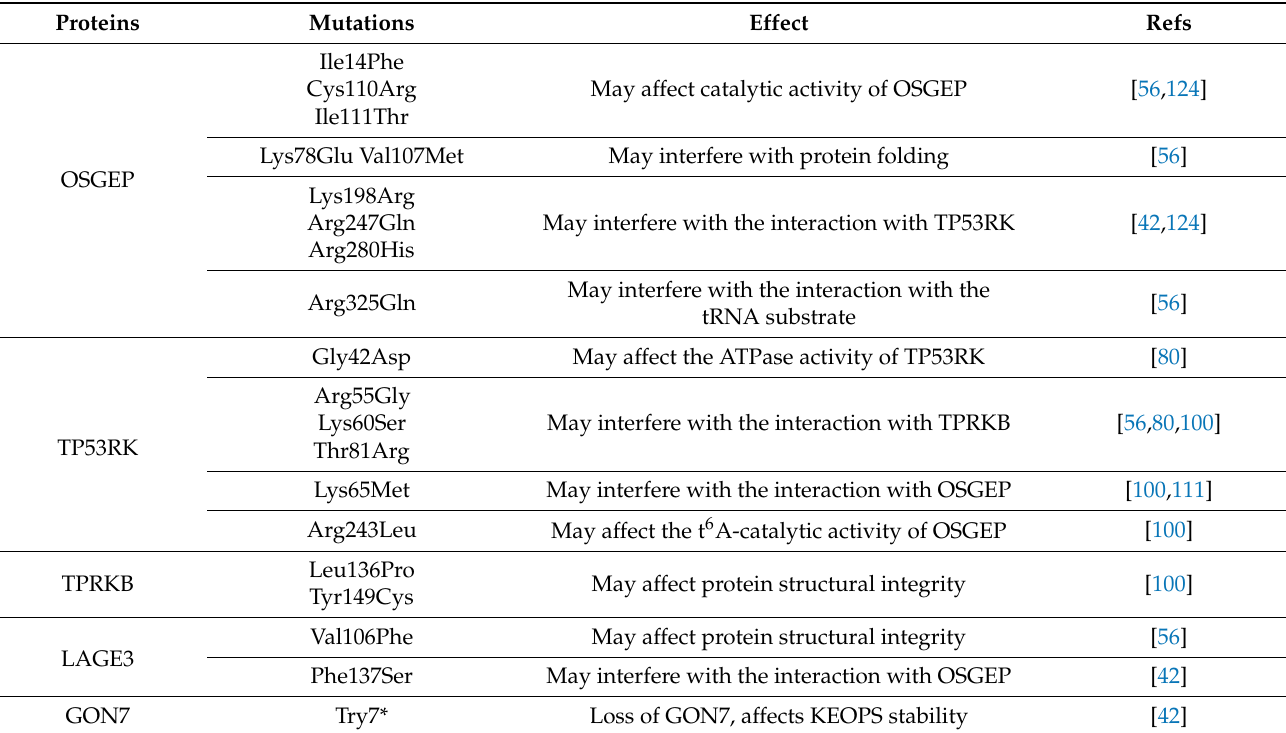
Table 5. KEOPS-related mutations identified in individuals with